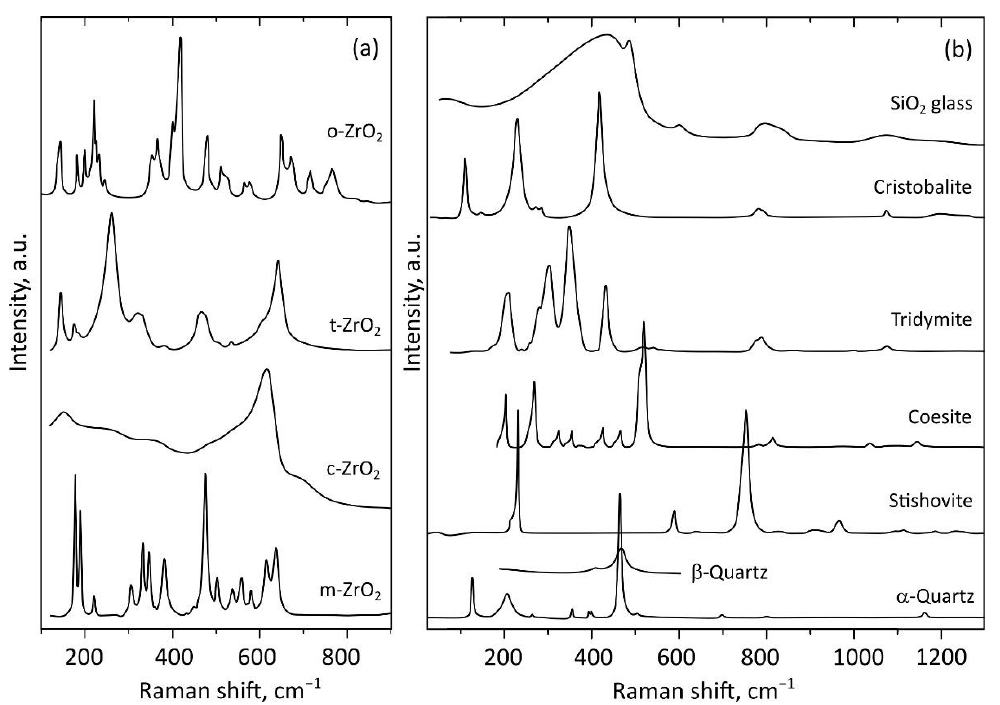
Figure 6. Raman spectra of ZrO 2 ( a ), and SiO 2 ( b ), polymorphs. Modified after [76,77].